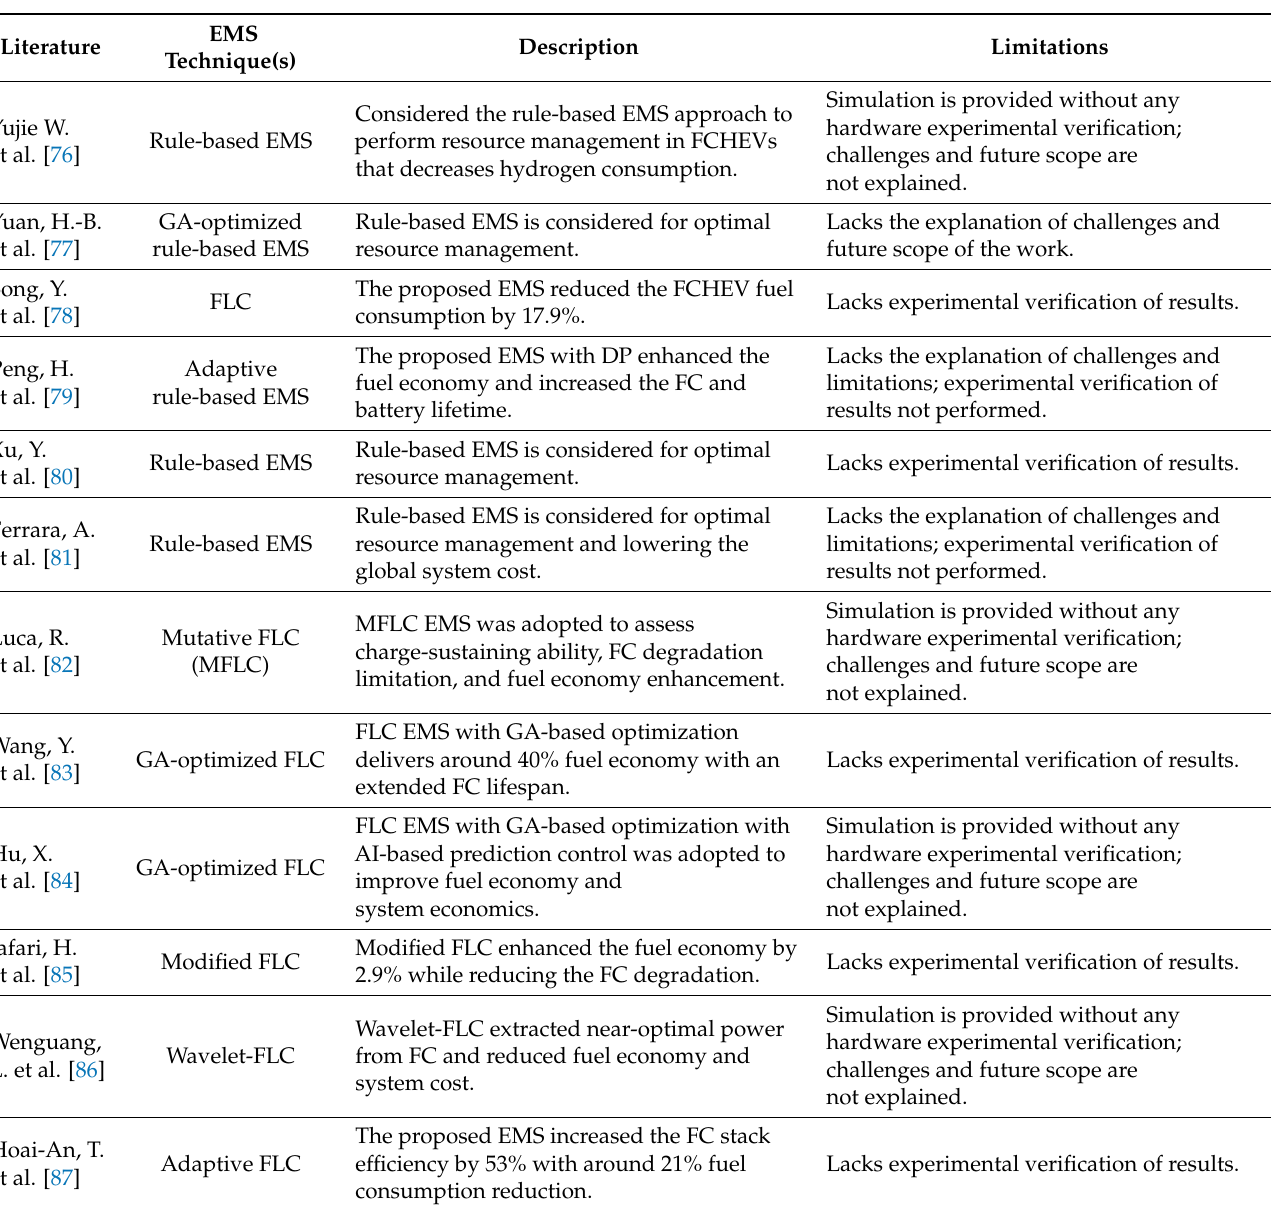
Table 8. Summary of the latest literature related to rule-based